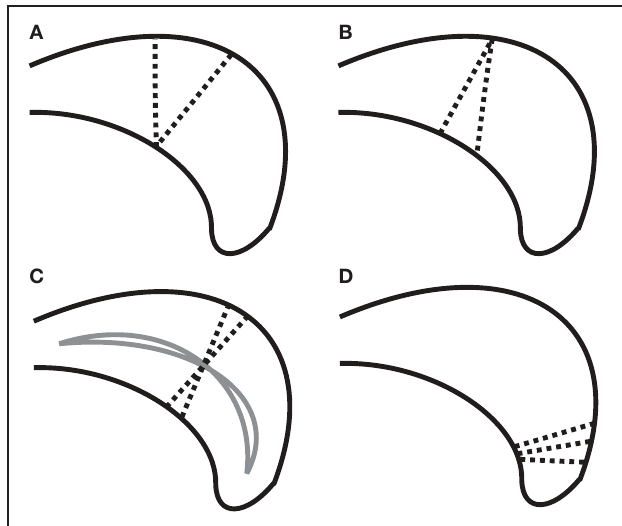
FIGURE 1 | Complexities in defining thickness (using dotted line segments) shown on a cartoon posterior callosum. (A) Problem with definition by minimal traversal distance (vertical line is shorter). (B) Line segments defining thickness cannot always be perpendicular to both boundaries simultaneously. (C) Sensitivity of thickness to median anchor point (solid lines) when perpendicularity to the median line is required. (D) High boundary curvature on only one surface causes fans of thickness-defining lines that nearly intersect; complicating attempts to define thickness using uniformly spaced grid